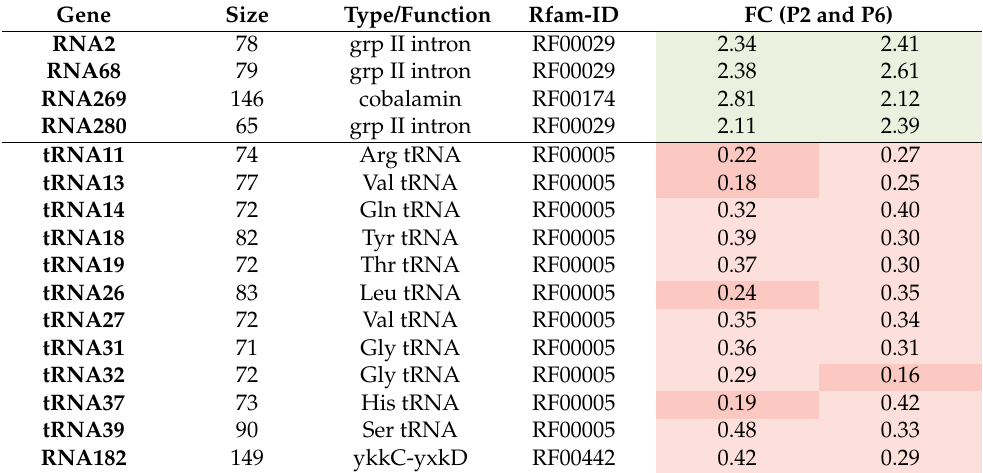
(abbreviations, colors, and selection criteria are as in Table 3). Two RNA genes regulated by SNF-gamma irradiation in both P2 and P6